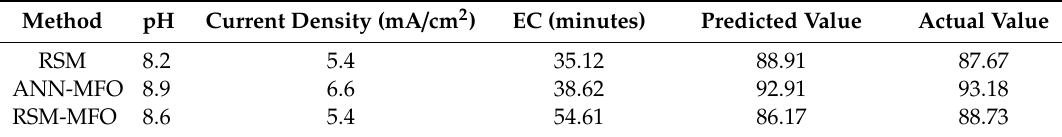
Table 8. Evaluation of optimal values for RSM and